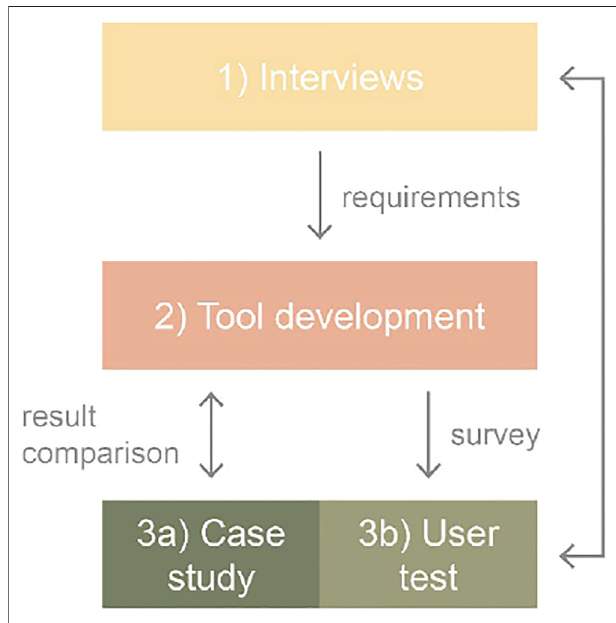
FIGURE 1 | Overview of the tool development